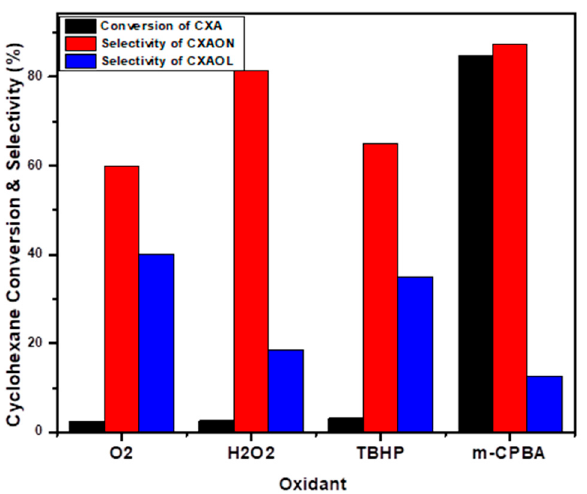
Figure 7. Oxidation of cyclohexane using different types of oxidants.